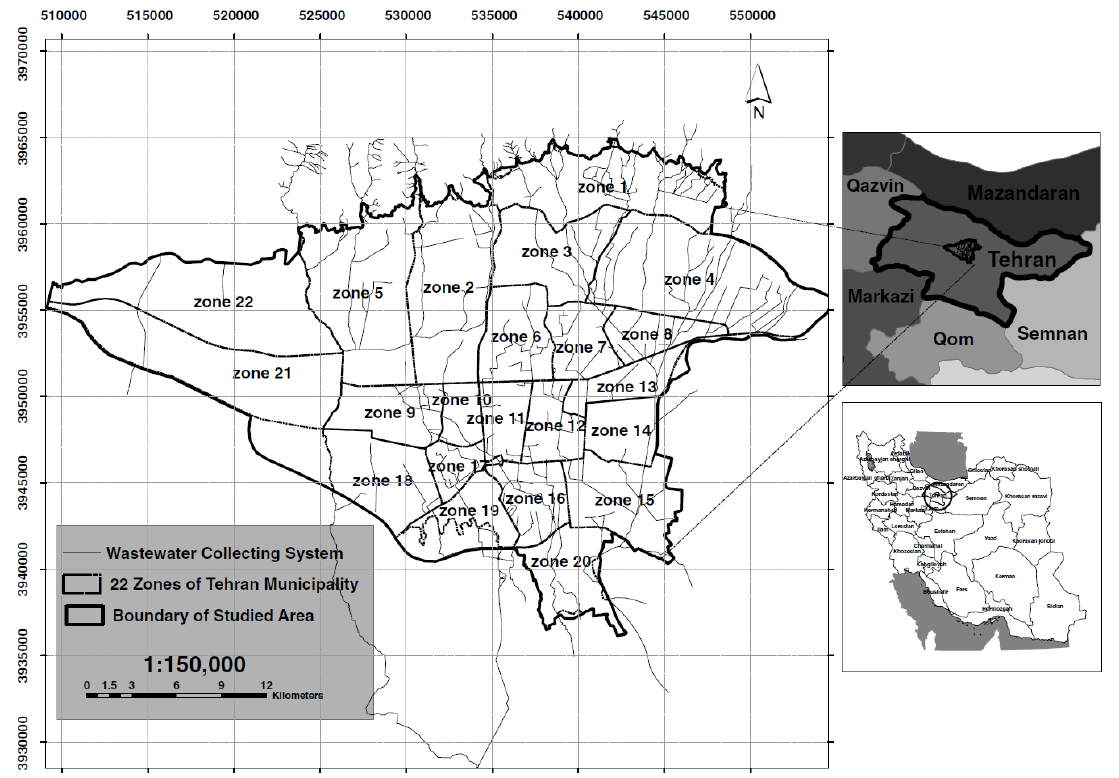
Figure 1. Tehran’s geographical position [30].